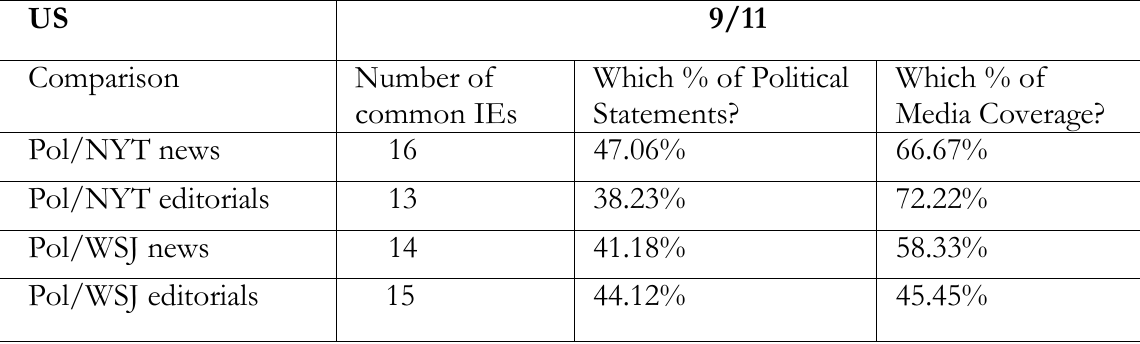
Table 5. Comparisons between political statements, first page news, and editorials in the